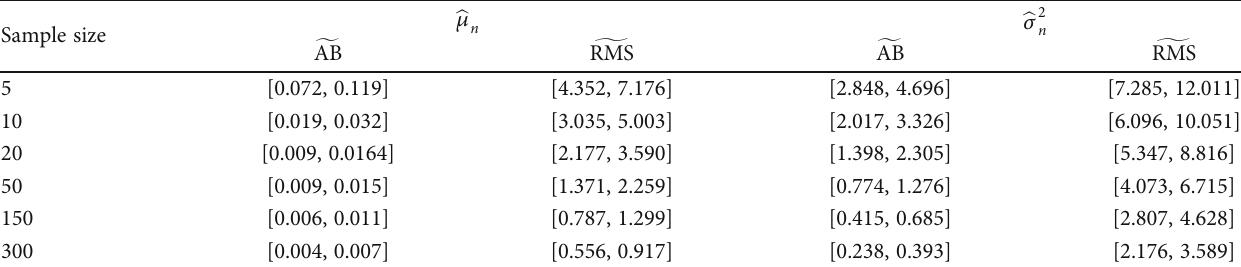
Table 1: Performance of f ML estimators for simulated data.